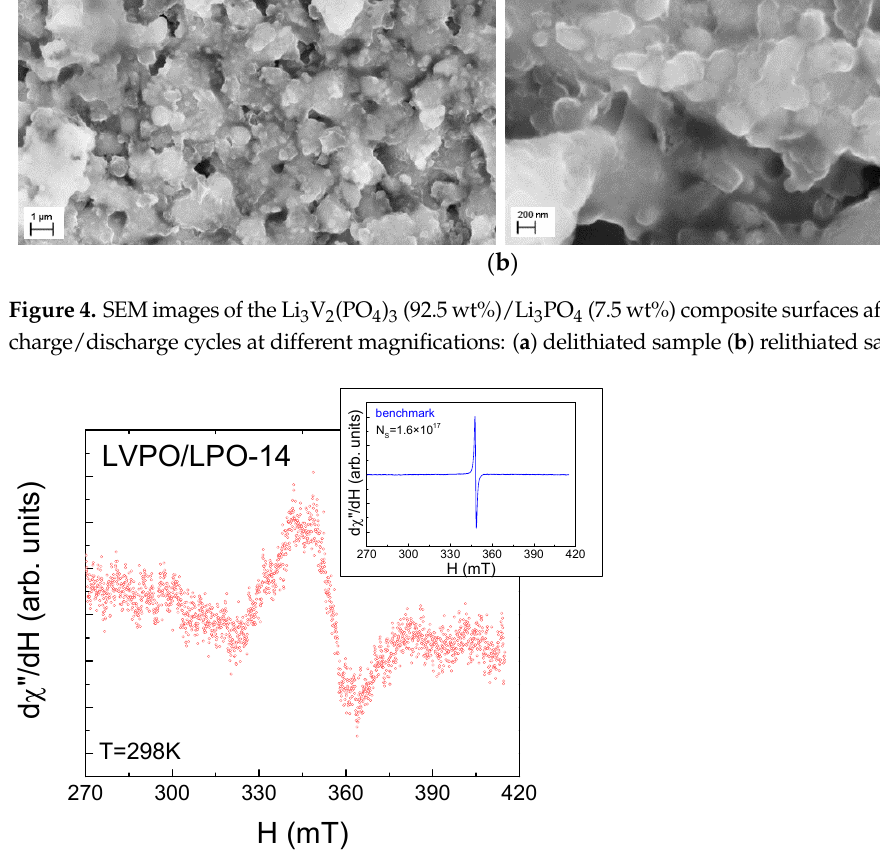
Figure 5. Electron resonance spectrum of the Li 3 V 2 (PO 4 ) 3 (86 wt%)/Li 3 PO 4 (14 wt%) composites at room temperature at the X-band frequency. Inset shows the electron spin resonance spectrum of the benchmark containing N s = 1.6·× 10 17 spins.